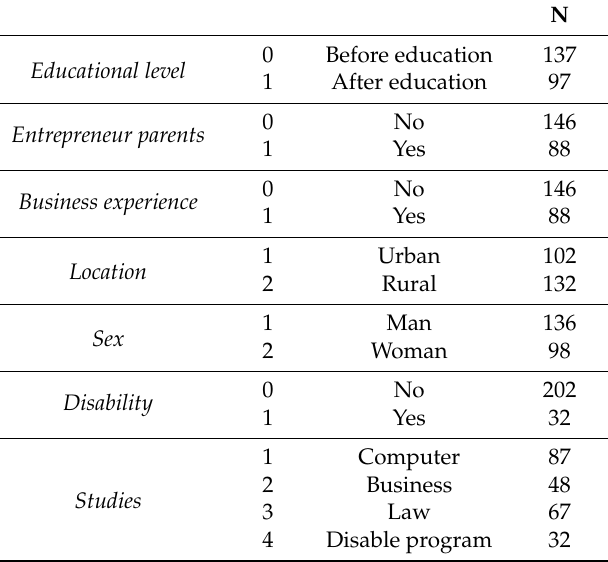
Table 1. Sample profile.